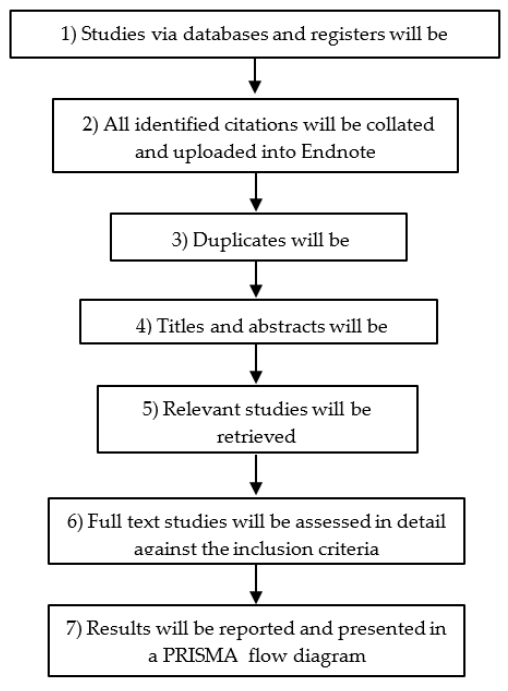
Figure 2. Study selection and its procedures.